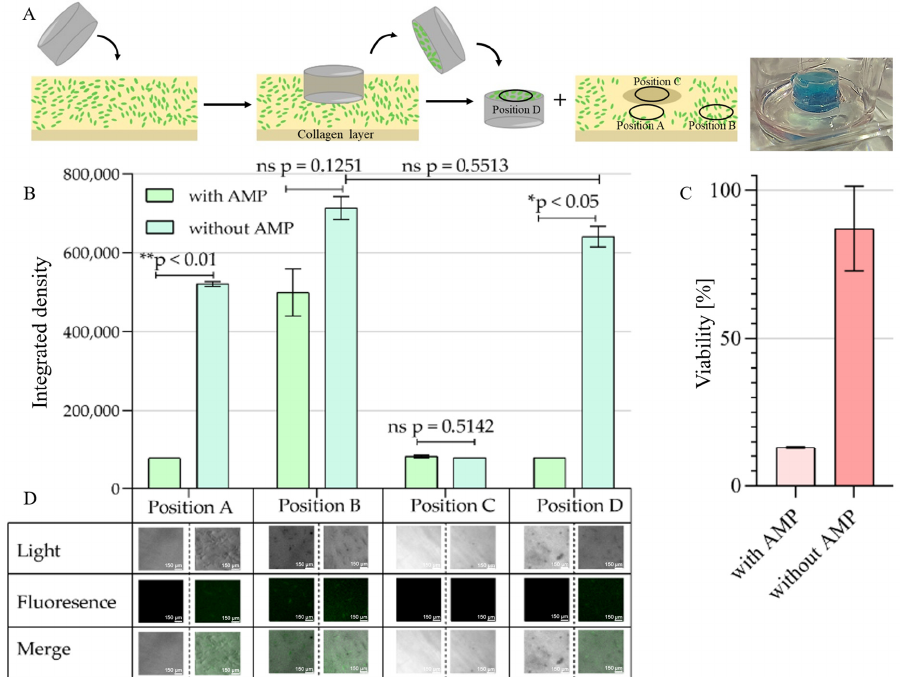
Figure 3. AA-EraGel-mediated removal and eradication of P. aeruginosa on a collagen matrix: proof- of-concept. ( A ) A collagen-based hydrogel mimicking a naturally occurring extracellular matrix for binding of pathogenic cells was “infected” with P. aeruginosa cells. The composite hydrogel loaded with C14R (10 µ g × mL − 1 ) was applied directly onto the P. aeruginosa cells with the trapping surface facing toward the collagen. ( B ) Computed integrated density per area of the fluorescent microscopy by FIJI software (version 1.53q) for each position. Position A: in close proximity to the composite hydrogel. Position B: far remote from the application site. Position C: directly under the application site. Position D: Trapping surface of the wound dressing material. Statistical analysis was performed with a Mann–Whitney U-test. ( C ) Viability of P. aeruginosa was visualized using a resazurin live/dead assay of the trapped cells on Position D. ( D ) Fluorescence microscopy and phase-contrast microscopy for each position at 630 × magnification. The photograph (top right) shows the experimental situation with the wound dressing composite lying in contact with the collagen matrix. To increase visibility, the top layer in direct contact with the collagen surface has been stained in blue with Indigotin I (E 132) (Erich Wutzig Inh. Andreas Saf, Sitzendorf, Germany). p values < 0.05 were considered significant. * denotes p < 0.05, ** <0.01, ns: not